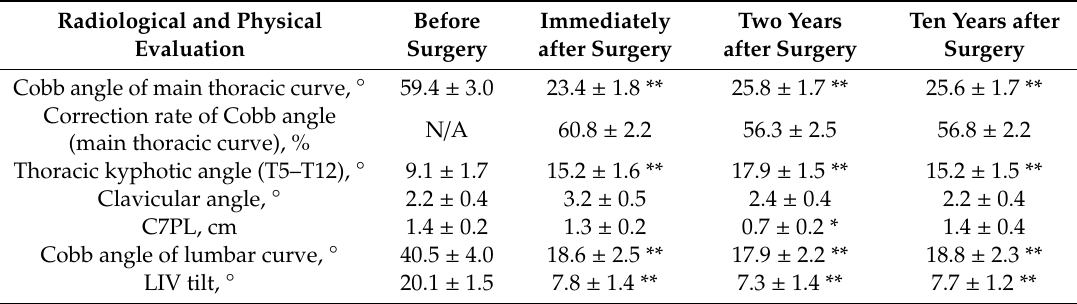
Table 2. Surgical results of skip pedicle screw